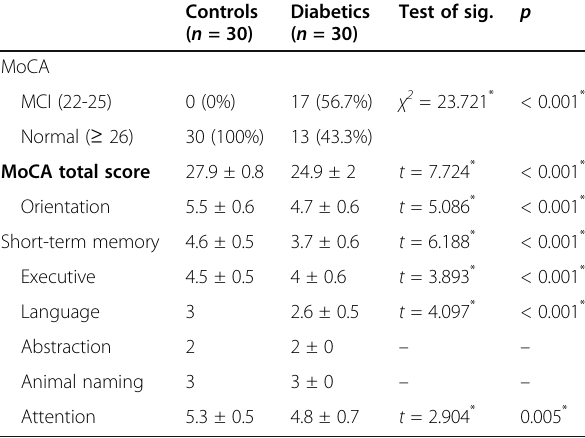
Table 2 Montreal Cognitive Assessment scale in diabetics and